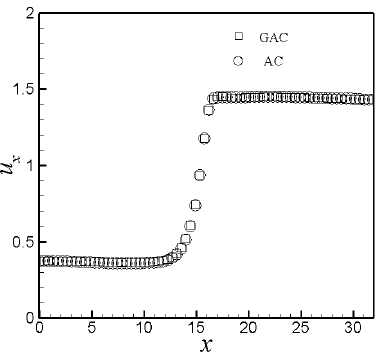
Figure 7. Mesh dependence of the velocity components through the horizontal at Wi = 1.0 using mesh of M1, M2, and M3.